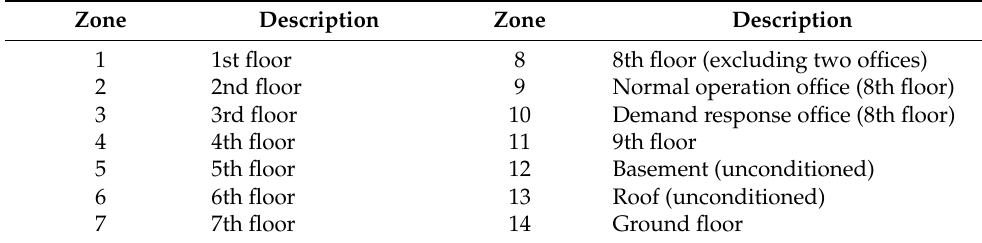
Table 2. Thermal zones